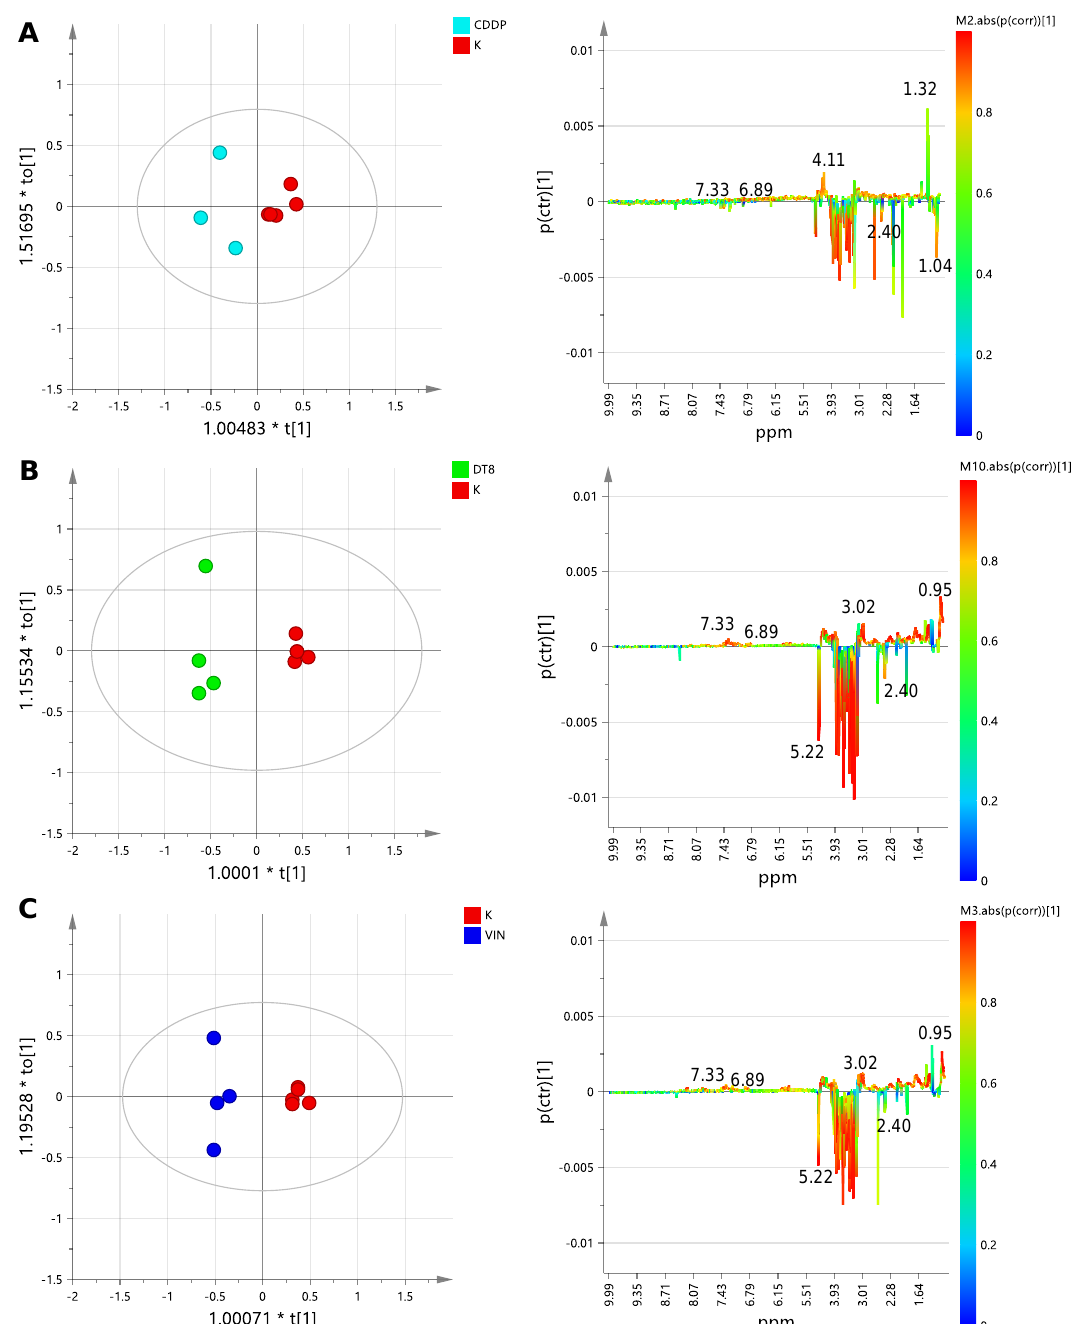
Figure 4. t[1]/to[1] orthogonal partial least squares discriminant analysis (OPLS-DA) score scatter plots (right) for ( A ) K vs. CDDP ( B ) K vs. DT-8 and ( C ) K vs. VIN cell lysates and the corresponding S-line plots (left) displaying the discriminant metabolites (the corresponding chemical shifts are reported in Table S1) and the related predictive loadings (Variables obtained from the 1 H-NMR spectra are colored according to the correlation scaled loading (p (corr)). Table 1. Statistical parameters of OPLS-DA models for the classification of 1 H-NMR experiments according to K (controls) and treated (CDDP, DT-8 and VIN). R 2 is described by R 2 X and R 2 Y, which represent the fraction of variance of the X and Y matrix, respectively, Q 2 = predictive capability.